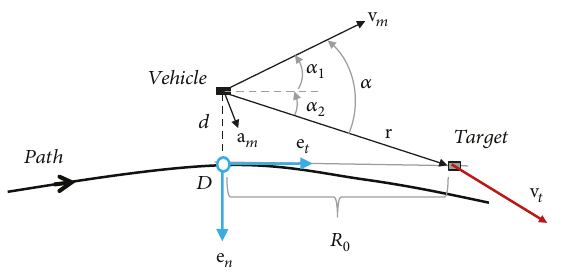
Figure 4: Linear model of continuous curvature path following.